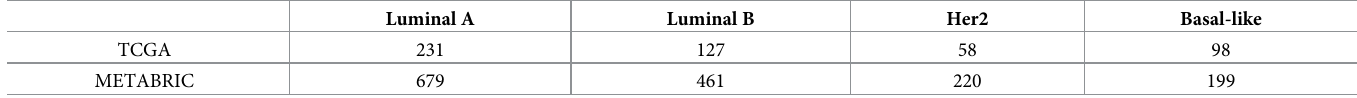
Table 1. Patients subtype distribution in TCGA and METABRIC. Subtypes considered in this study are highlighted in